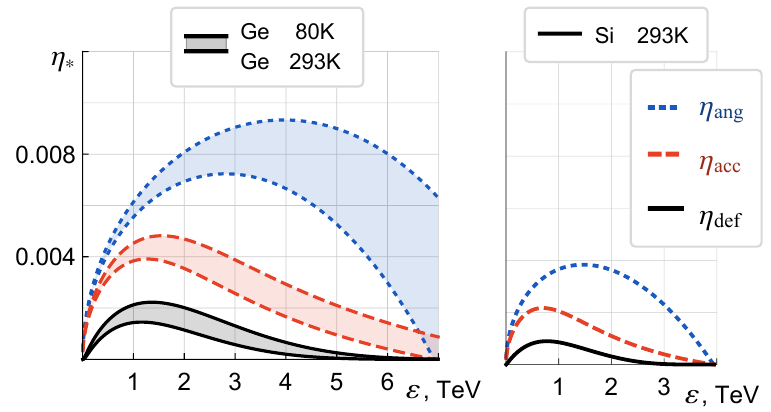
Figure 5 . Angular acceptance factor (cid:17) ang (dotted blue curves), acceptance factor (cid:17) acc (dashed red curves), de(cid:13)ection e(cid:14)ciency of 8 cm bent crystal (cid:17) def (solid black curves) as functions of channeled particle energy in germanium (on the left) and silicon (on the right) crystals. Curvature radius is 7.5 m for all